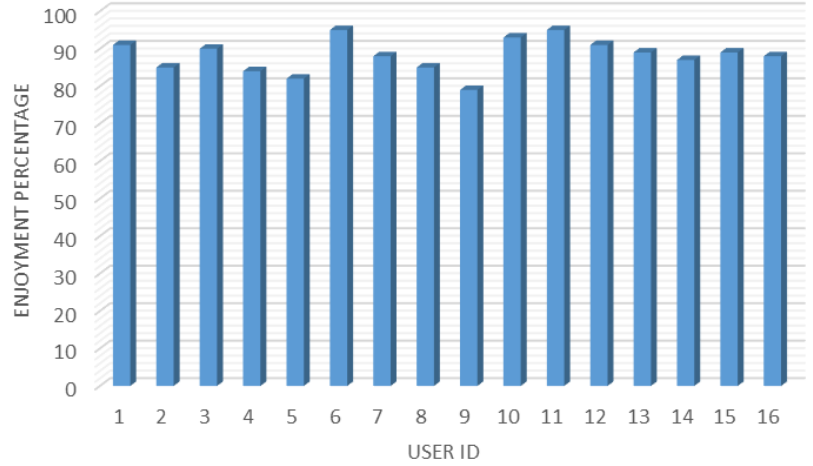
Figure 9. Average enjoyment time when the obese child interacted with the robot system.